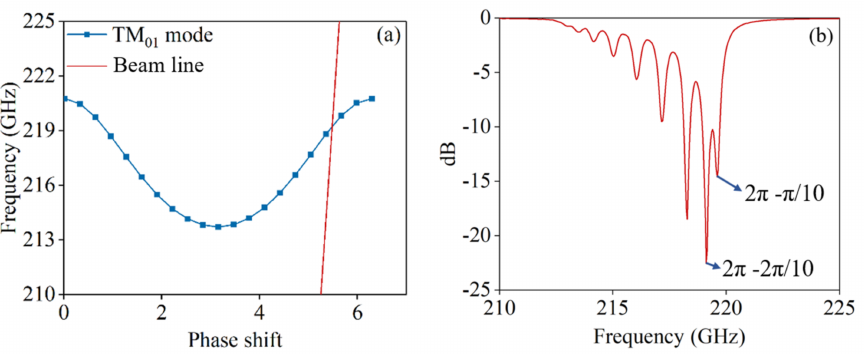
Figure 5. ( a ) The dispersion curve of the TM 01 mode and electron beam; the frequency of the intersection is slightly lower than the frequency of the 2 π − 2 π /10 mode. ( b ) The reflection parameter S 11 of the traveling wave output structure; the curve of the segment near 2 π − π /10 mode and 2 π − 2 π /10 mode is less than − 10